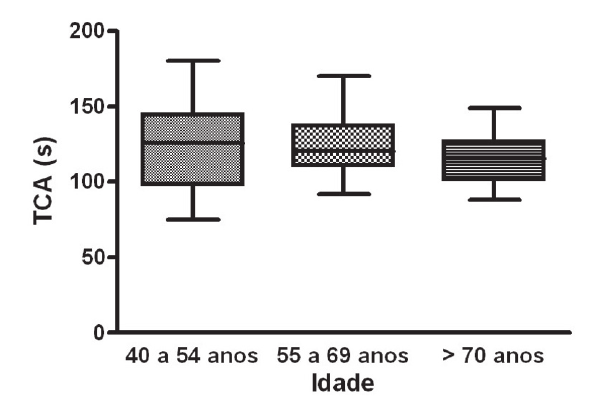
vs Sexo (p = 0,0492) FINAL